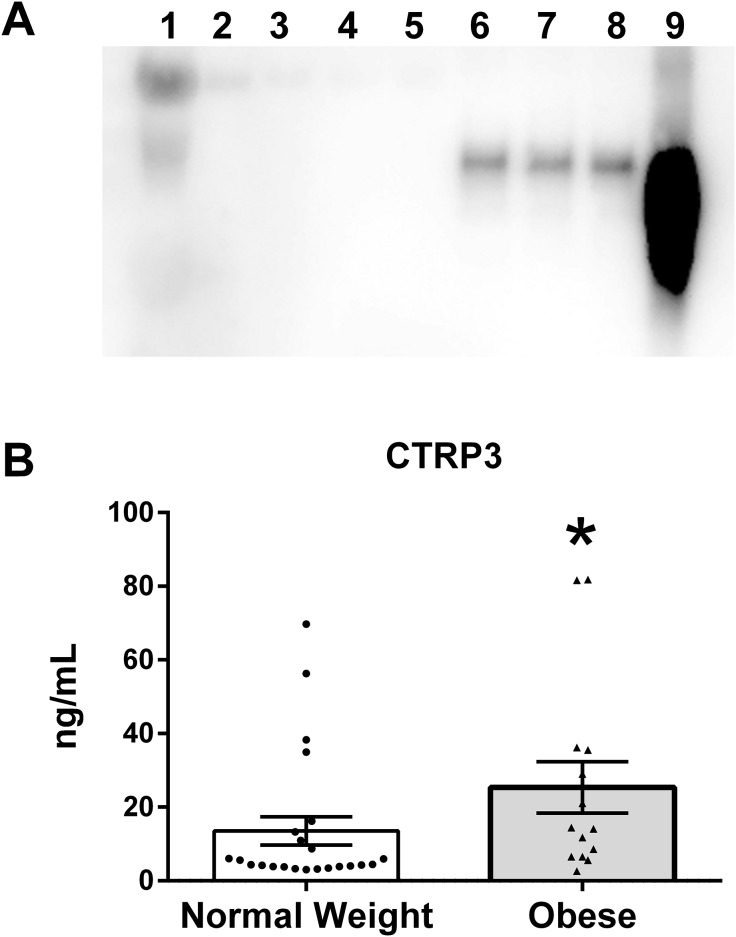
CTRP3 in human breast milk (BM).(A) Immunoblot analysis of whole BM (lane 1), unbound protein solution samples (lanes 2–5) and immunoprecipitate samples (lanes 6–9). BM samples were immunoprecipitated with vehicle only (lanes 2 and 6), normal serum (lanes 3 and 7), anti-CTRP1 (lanes 4 and 8), or anti-CTRP3 antibody (lanes 5 and 9). (B) BM CTRP3 concentration in normal weight compared with obese mothers (*p < 0.05 vs. normal weight group). Values are mean ± SEM, and dots, and triangles represent individual data points from individual participants.